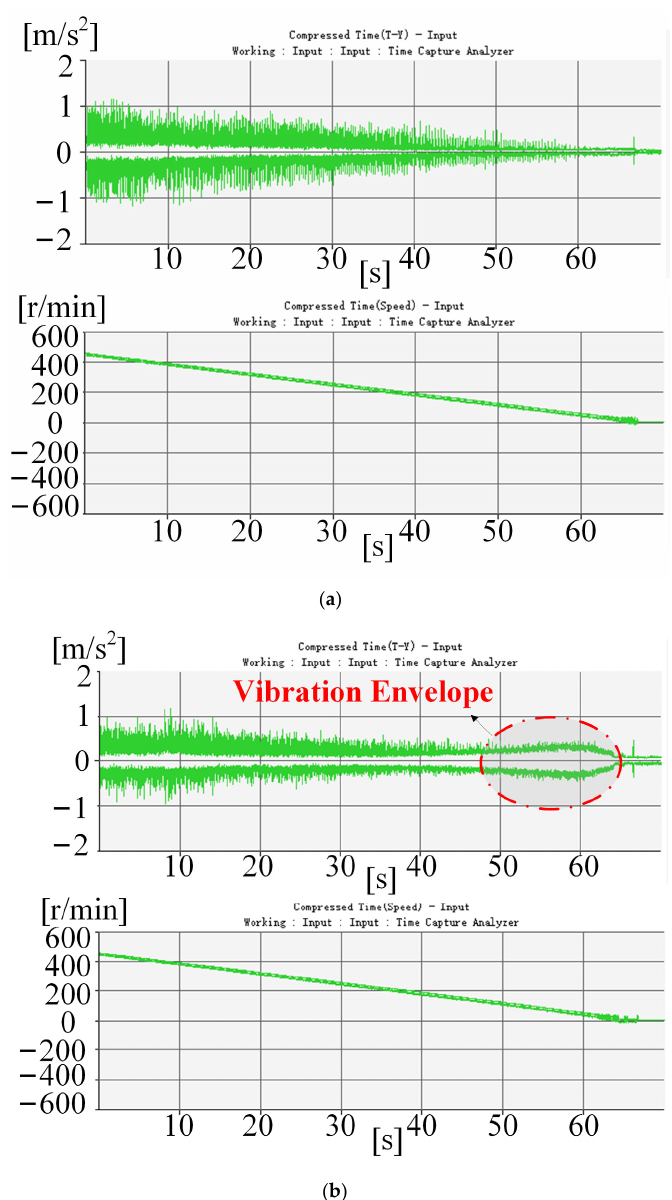
Figure 4. Time domain diagram of the test bearing in the Y direction. ( a ) Time ‐ domain diagram of the frictionless vibrations, ( b ) time ‐ domain diagram of vibrations with friction.